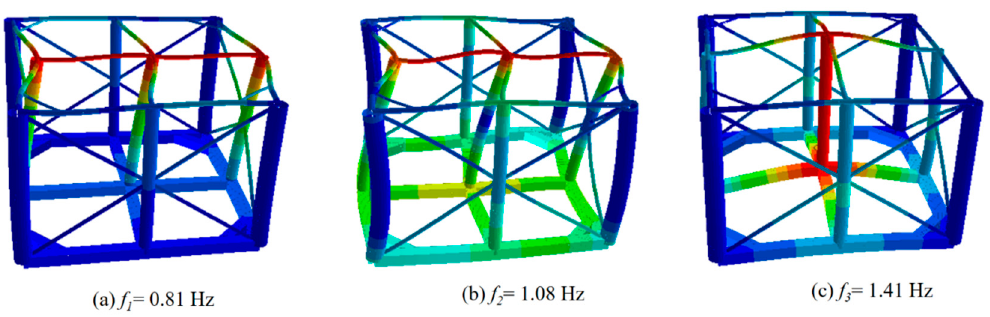
Figure 7. Deformation of the cage in calm water (unit: m).